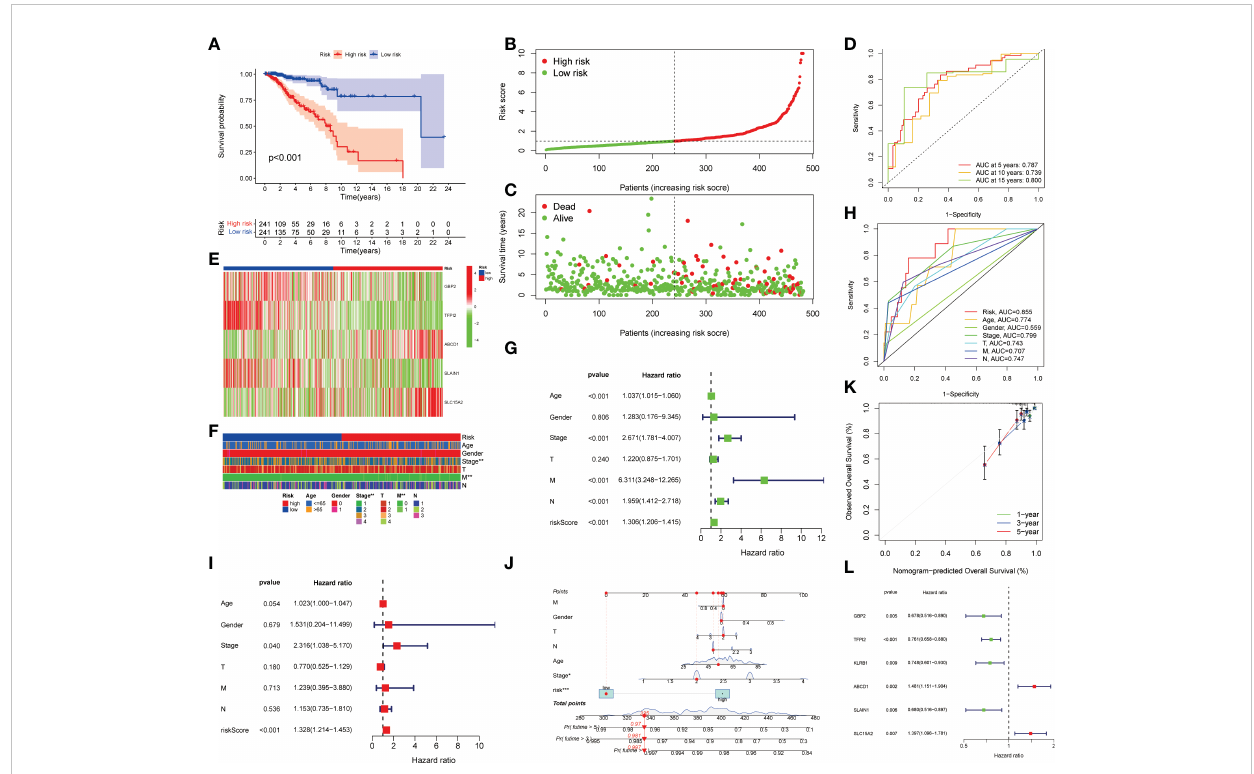
FIGURE 3 Prognostic value validation of the LNPRS in the training cohort. (A) The survival curve of patients in the high and low LNPRS groups. (B, C) The relation between the LNPRS and survival time of the patients with breast cancer. (D) The ROC curves of the LNPRS model for the TCGA cohort. (E) The heatmap of gene expression in different LNPRS groups. (F) The heatmap of patient clinical features in high and low LNPRS groups. (G – I) The P-values, HR, and 95% con fi dence interval of clinical features and riskScore by univariate (G) and multivariate (I) Cox regression analysis. (H) The AUC of clinical features and riskScore. (L) The P-value and HR of prognostic-related genes. (J) Nomogram diagram based on the LNPRS model. (K) The calibration plot of the